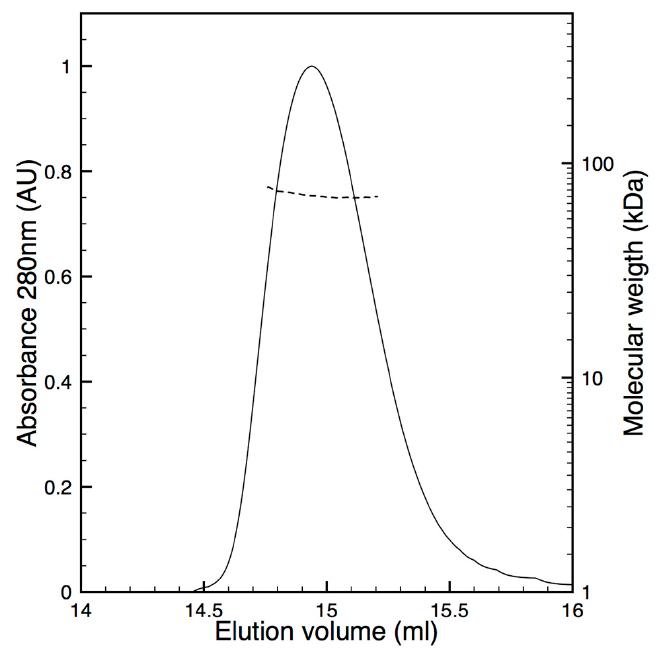
Figure 4. Oligomeric state analysis of pure hBChE-7. After separation of pure hBChE-7 on Superdex 200 Increase 10/300 equilibrated in 20 mM Tris pH 8.0, 150 mM NaCl, the major UV peak (plain line) was analyzed in line by multi-angles light scattering and a constant molecular weight of 70 + 2 kDa was measured (dashed line).